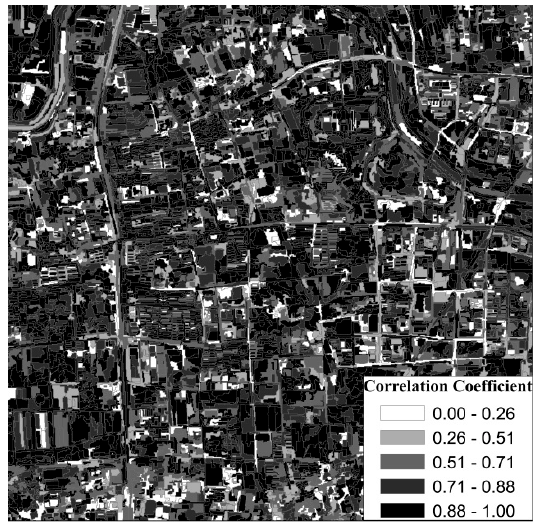
Figure 13. Correlation coefficient map for the GF-1 images in 2016 and 2017.